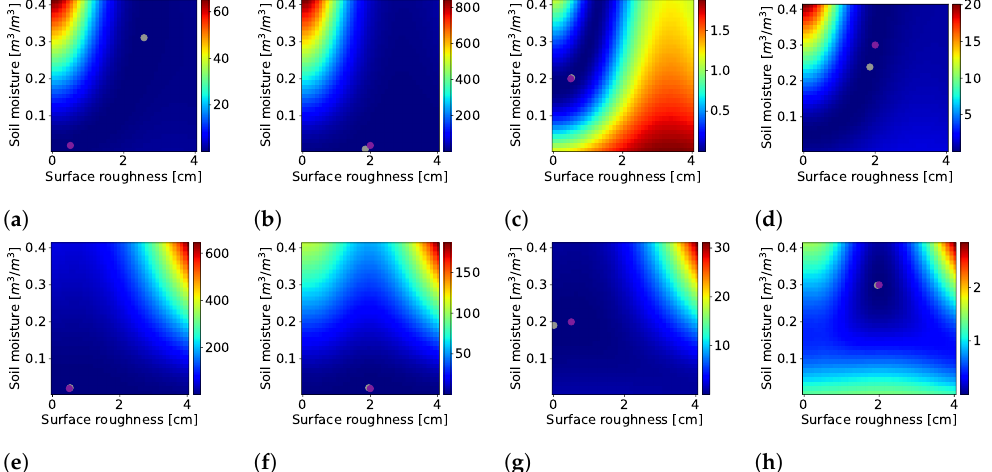
Figure 10. Cost function of two DDMs with SP incidence angles 10° and 20°. The purple dot where the true value of soil moisture and surface roughness. The gray dot is where the minimum value of the plot lies. ( a ) Grassland land cover, soil moisture = 0.02m 3 m − 3 , σ h = 0.5cm. ( b ) Grassland land cover, 0.02m 3 m − 3 soil moisture, and 2cm RMS surface roughness. ( c ) Grassland land cover, soil moisture = 0.2m 3 m − 3 , σ h = 0.5cm. ( d ) Grassland land cover, soil moisture = 0.3m 3 m − 3 , σ h = 2cm. ( e ) Mixed forest land cover, soil moisture = 0.02m 3 m − 3 , σ h = 0.5cm. ( f ) Mixed forest land cover, soil moisture = 0.02m 3 m − 3 , σ h = 2cm. ( g ) Mixed forest land cover, soil moisture = 0.2m 3 m − 3 , σ h = 0.5cm. ( h ) Mixed forest land cover, soil moisture = 0.3m 3 m − 3